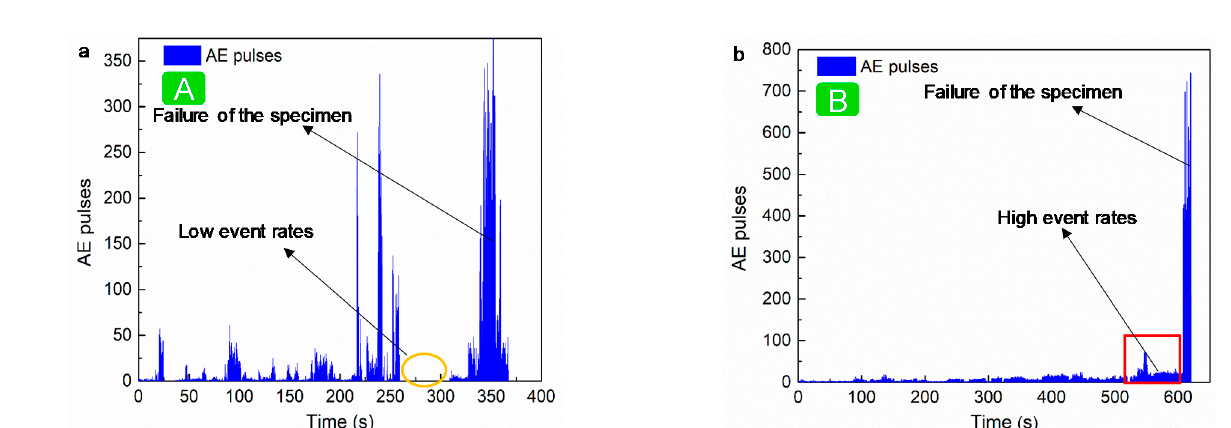
Figure 2. Temporal evolution law of acoustic emission (AE) pulses on the process coal specimen’s failure. ( a ) specimen A, ( b ) specimen B. Table 1. Microseismic ( MS) indicators for early warning of rockburst risk.